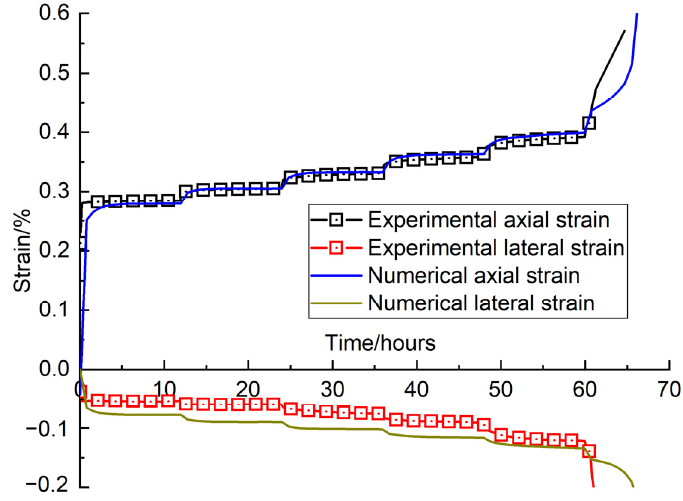
Figure 14. Comparison of axial and transverse strain vs. time curves in numerical simulation and in laboratory tests.